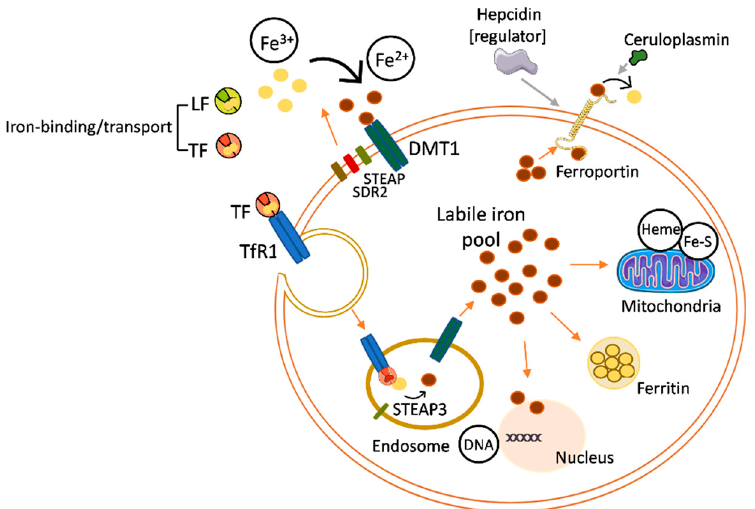
Figure 2. Summary of the iron regulation mechanisms within the cell. Abbreviations: DMT1, divalent metal transporter 1; DNA, deoxyribonucleic acid; Fe 2+ , ferrous ion; Fe 3+ , ferric ion; Fe-S, iron sulphide; LF, Lactoferrin; SDR2, stromal cell-derived receptor 2; STEAP, six transmembrane epithelial antigens of the prostate family; STEAP3, STEAP family member 3 metalloreductase; TF, transferrin; TfR1, transferrin receptor 1. Self-created figure using elements with Creative Common (CC)